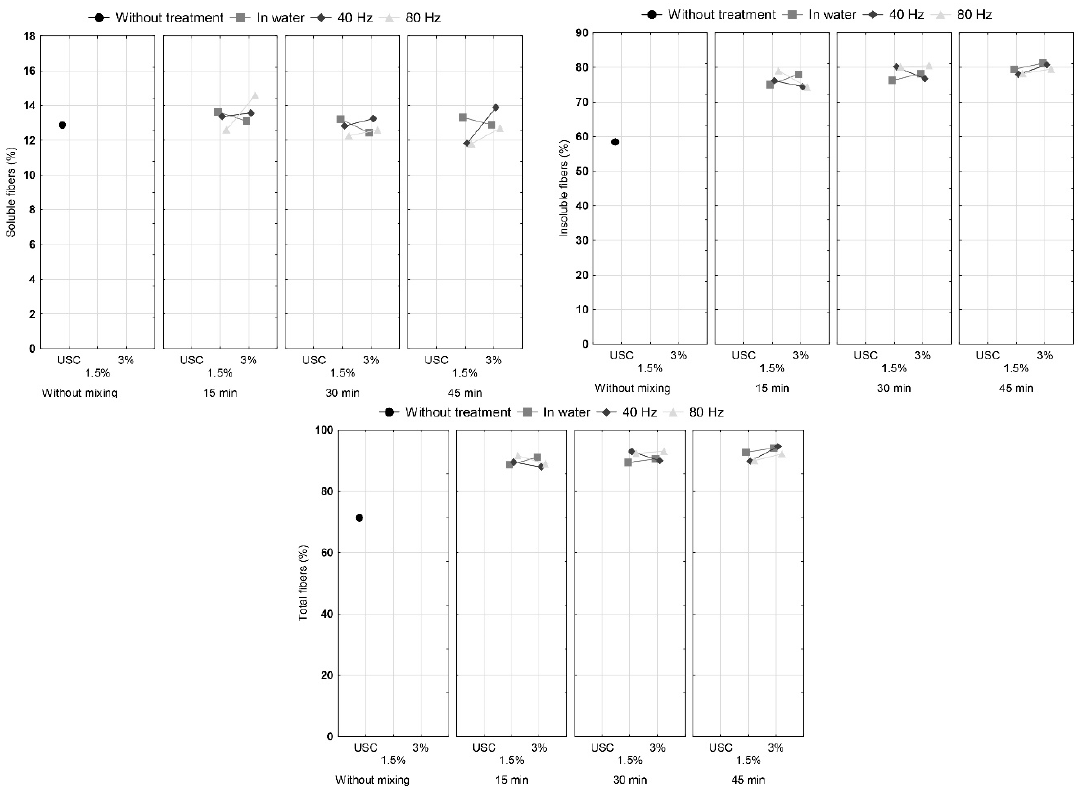
Figure3. Contentofinsoluble, Figure 3. Content of insoluble, soluble and total fibers in cocoa shell before and after the HVED treatment. Table 2. Main effects analysis of variance.